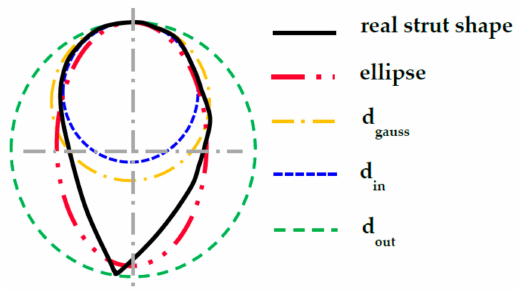
Figure 4. Visual 2D representation of elements used for dimensional struts